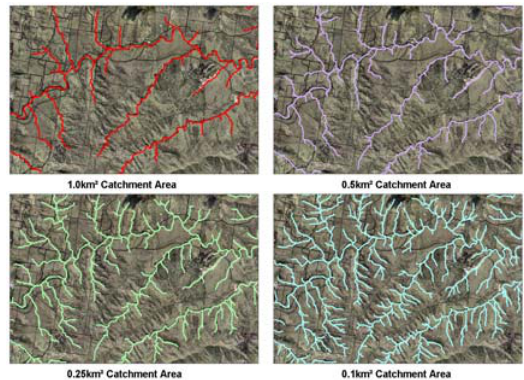
Figure 9. Sample Stream Order Maps, Various Catchment Input Resolution